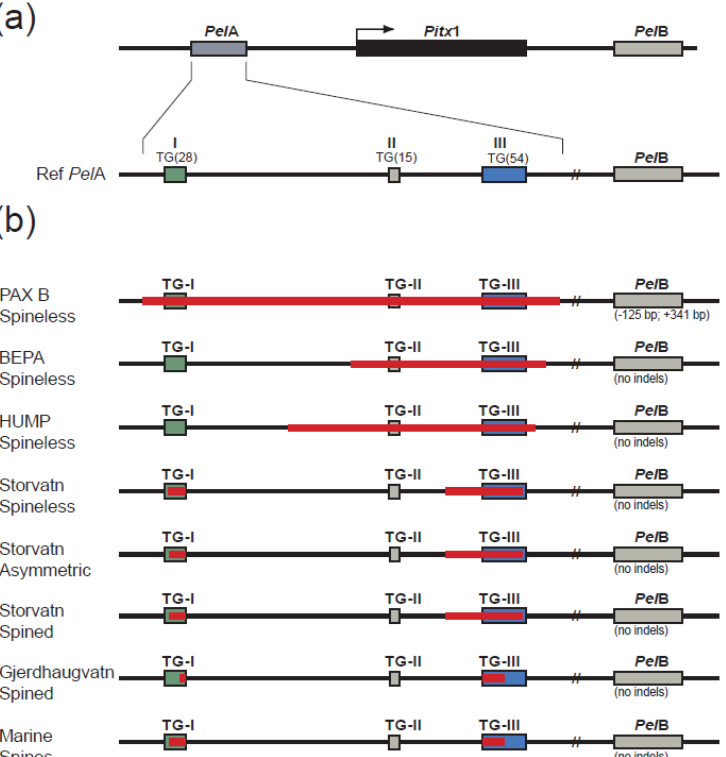
Figure 5. ( a ) The relative positions of the Pitx 1 gene and its upstream and downstream enhancers, Pel A and Pel B. In addition, the relative positions within Pel A of TG-repeat I (green), TG-repeat II (grey), and TG-repeat III (blue) are also shown. The approximate downstream position (out of scale) of Pel B (grey) is indicated as well, as are the number of TG-repeats at TG-repeat I, II, and III for the reference sequence (GU130435) from Salmon River, British Columbia. ( b ) Polymorphism at TG-repeat I, II, and III located at Pel A, and at Pel B in spineless sticklebacks from three previously published studies from Paxton Benthic Lake (PAXB), Bear Paw Lake (BEPA), and Hump Lake (HUMP) from the west coast of North America [28]. Spineless, asymmetric-spined, and symmetric-spined sticklebacks from the present study sites of Lake Storvatnet (Storvatn), Lake Gjerdhaugvatnet (Gjerdhaugvatn), and the marine sample (Marine) in sub-Arctic Norway at the north-east coast of Europe are also shown. Missing regions at Pel A compared with the reference sequence are indicated in red.